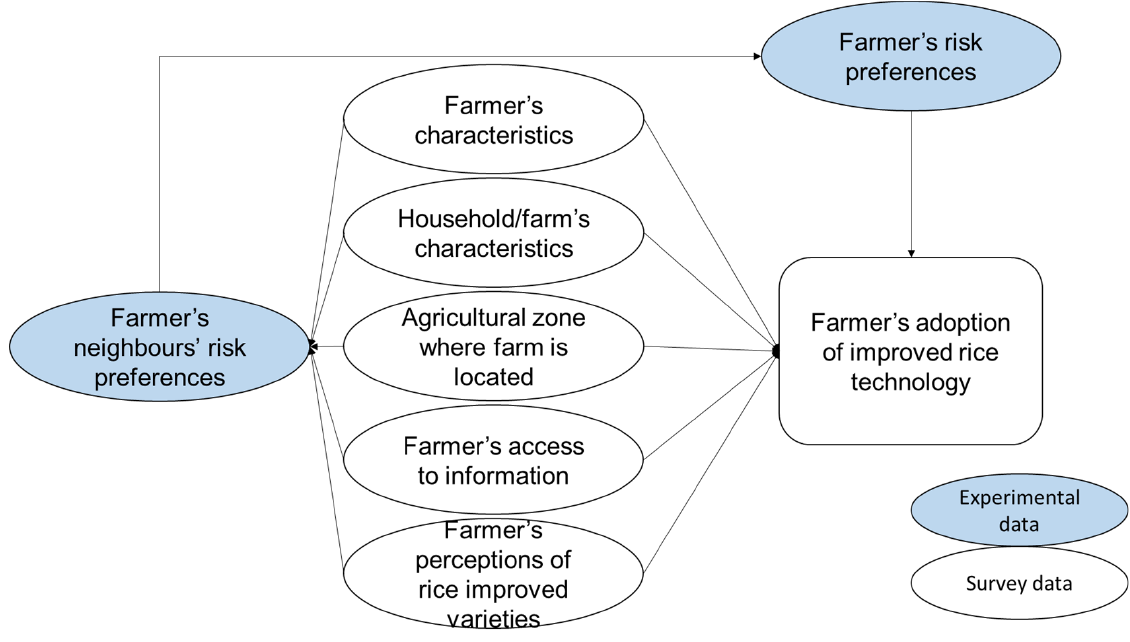
Figure 1. Conceptual framework for farmer’s adoption of improved rice technology.